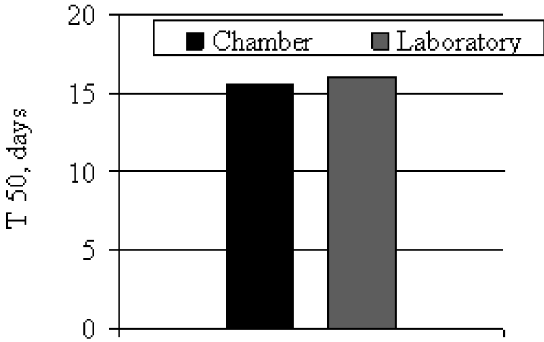
Figure 2. The germination rate (T